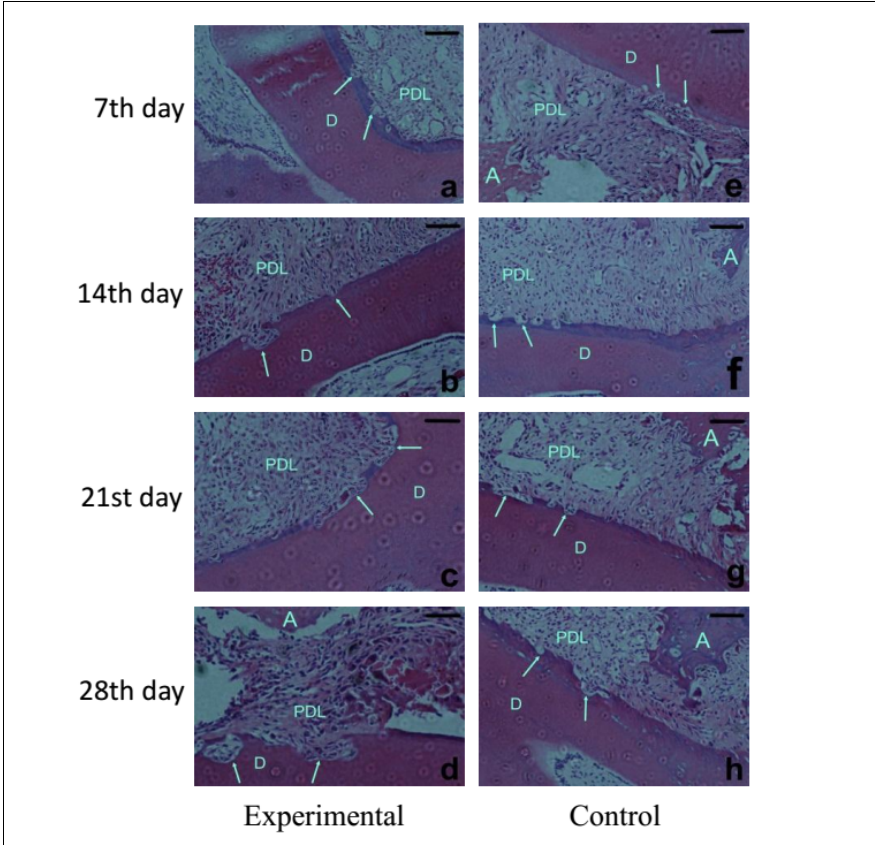
Figure 1. Photomicrographs of hemi-maxillae sections stained with H&E. The mesial side of the periodontal ligament and buccal root of the first molar are visible. a,b,c,d represent the resorption lacunae of the control group on days 7, 14, 21, 28; e,f,g,h represent the resorption lacunae of the experimental group on days 7, 14, 21, 28. PDL: periodontal ligament; D: dentin; A: alveolar bone. arrows: resorption lacunae (magnification